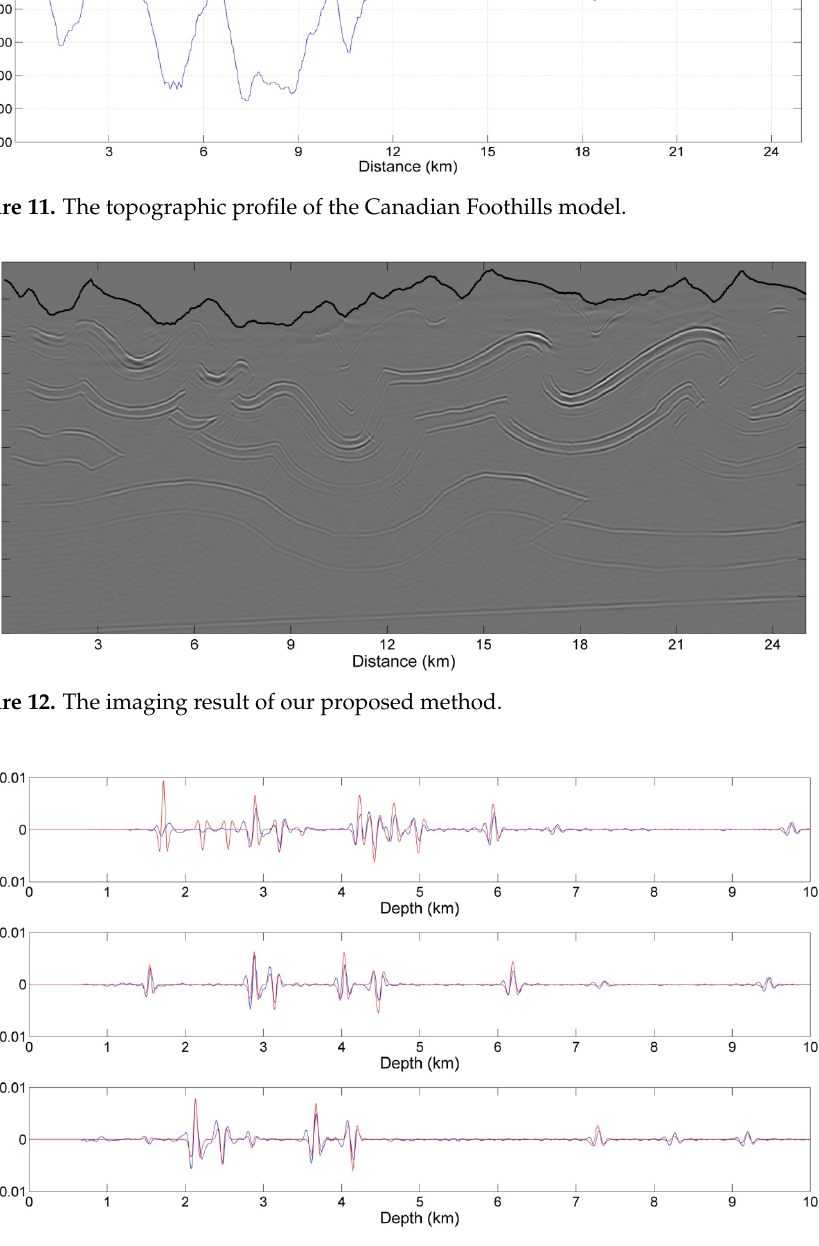
Figure 13. ( a ) Comparison of the imaging amplitudes of our proposed method (blue line) and the theoretical amplitudes (red line) at log L3; ( b ) Comparison of the imaging amplitudes of our proposed method (blue line) and the theoretical amplitudes (red line) at log L4; ( c ) Comparison of the imaging amplitudes of our proposed method (blue line) and the theoretical amplitudes (red line) at log L5.